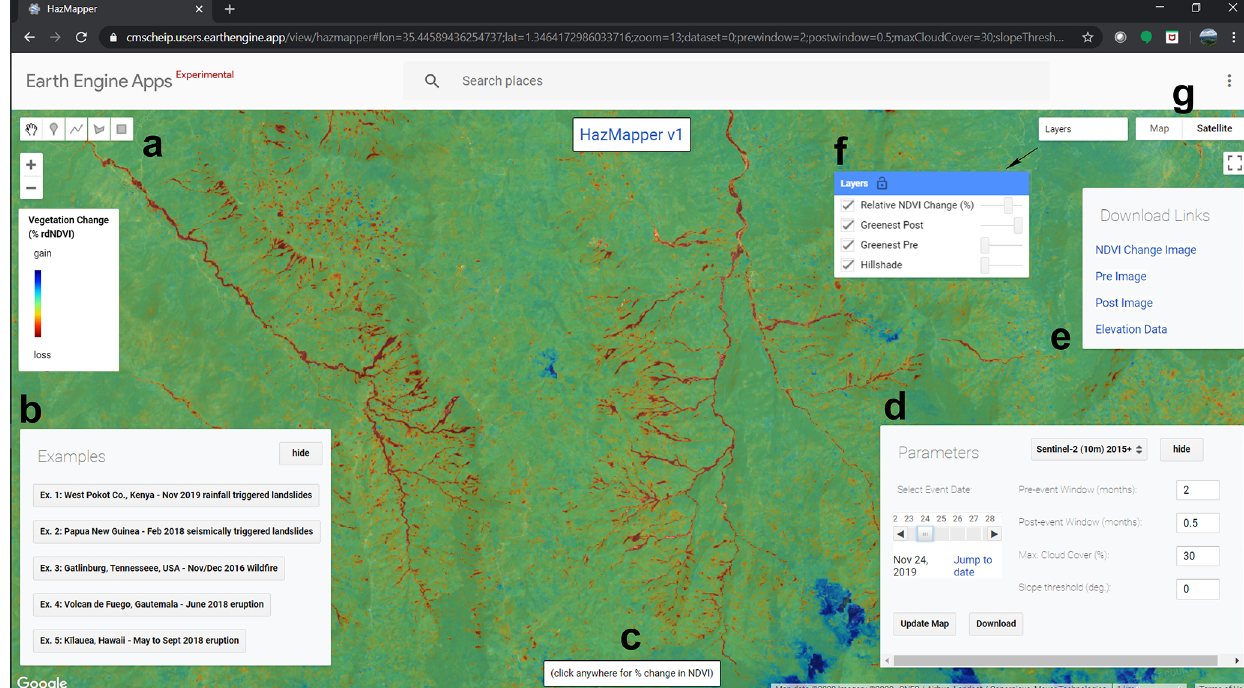
Figure 1. User interface of the HazMapper application in Google Earth Engine. Moving counterclockwise around the interface: (a) digi- tization tools allow the user to digitize features of interest as points, lines, or polygons. (b) An example window allows users to explore five curated examples. Data on this map show results from Example 1: November 2019 rainfall-triggered mass wasting, West Pokot County, Kenya. (c) Users can display rdNDVI (relative difference in the normalized difference vegetation index) results from a single point by click- ing at a location on the map. The displayed result is in the format “(latitude, longitude), rdNDVI result.” (d) The parameters window allows users to select the various input values, as further explained in Table 1 and Sect. 4.2 of the Discussion. This panel also contains the Download button, which initiates the population of download links as seen in E. The Update Map button will restart data processing following user modification of the event parameters. (e) Download links for the resulting datasets allows users to save data directly to their local disk for further analysis and processing as desired. If any digitized geometries are present, a digitized-geometries link will allow users to save a Google Earth-compatible keyhole markup language (KML) file. (f) The Layers pane contains four consistent layers, including a hillshade DEM, the greenest composite pre- and post-event pixel images, and the rdNDVI image. Users can choose to turn on/off each layer as well as to adjust the layer transparency. (g) The default basemaps available in Google Earth Engine include satellite imagery with or without labels and a standard borders map with or without terrain data. Notice that the URL reflects current HazMapper parameters. URLs are automatically updated during use of the app. This design feature facilitates sharing of finds in HazMapper among colleagues by simply copying and pasting the URL into an email or instant message chat screen, for example.